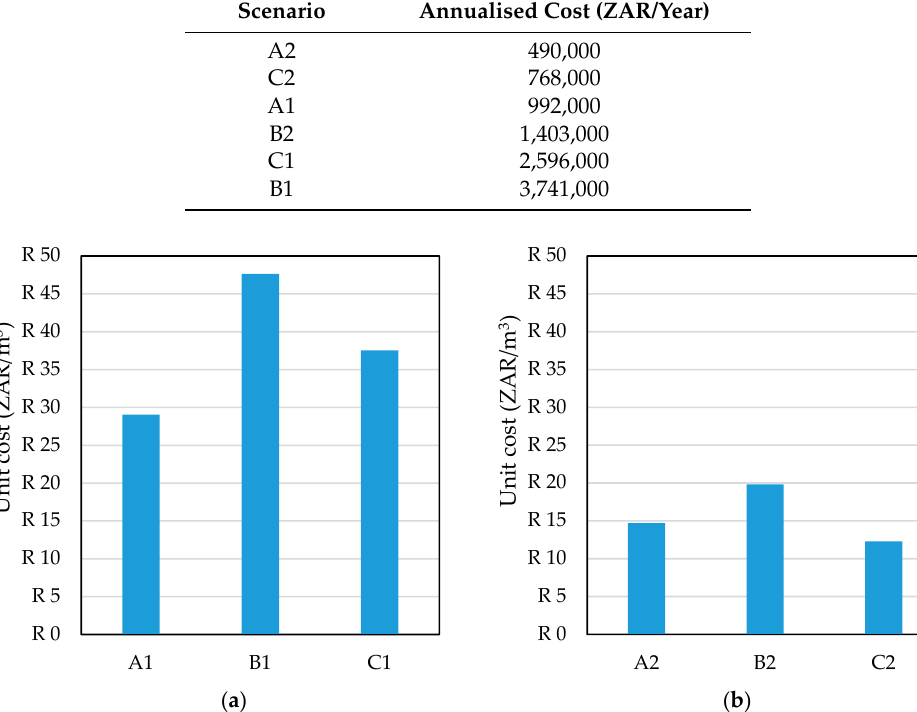
Table 6. Annualised cost of each of the stormwater harvesting scenarios. Scenario